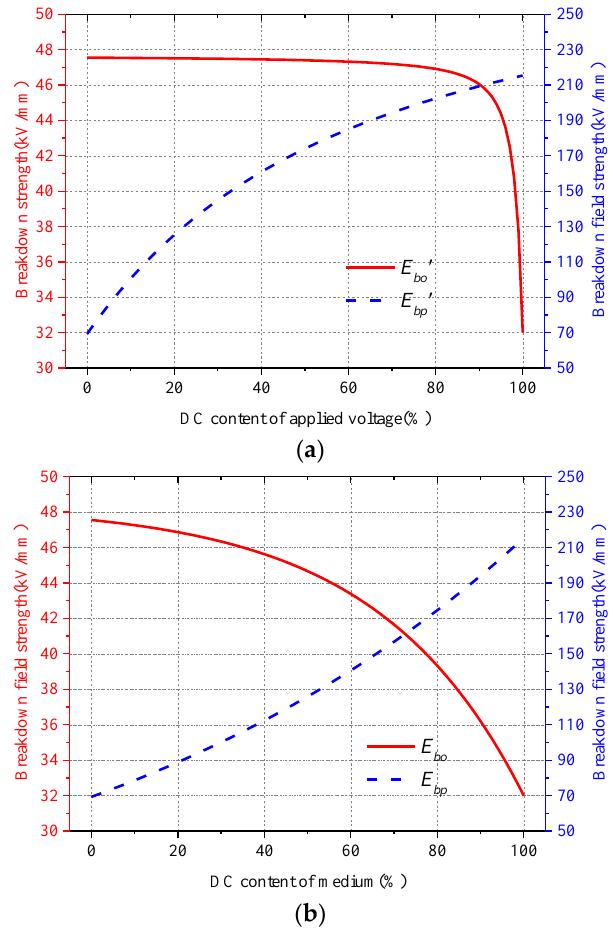
Figure 11. Breakdown strengths of transformer oil and pressboard in composite insulation. ( a ) Breakdown strength corresponding to the DC content of applied voltage; ( b ) Breakdown strength corresponding to the DC content of medium.